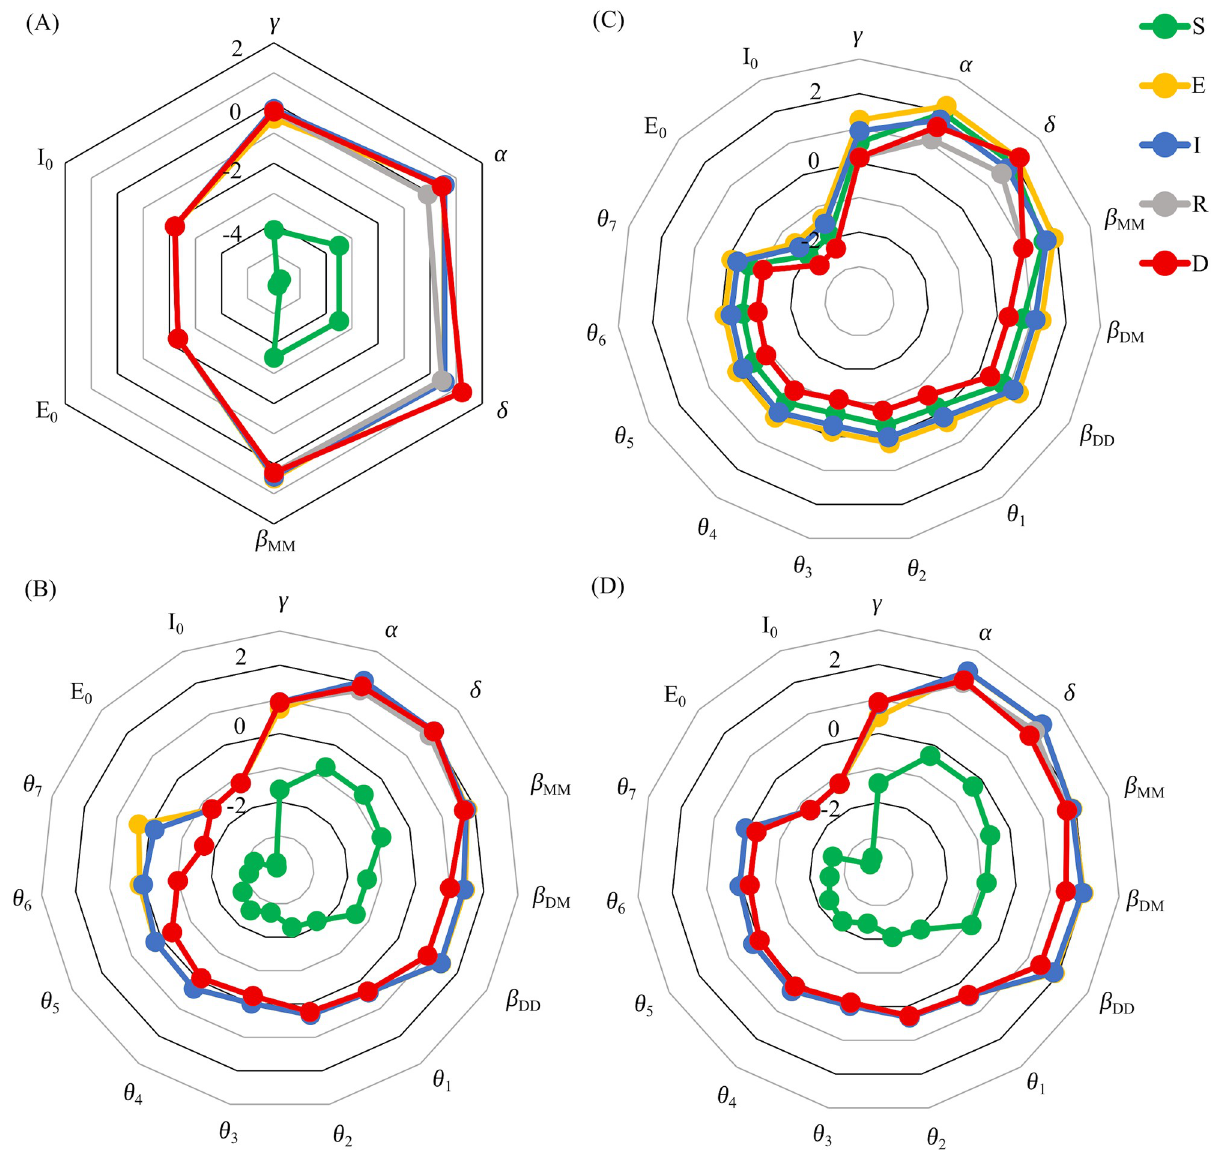
Fig 11. Relative sensitivities of the outputs of the Distancing-SEIRD model on the fit data. Perturbations of Eqs (3) and (4), to perturbations in the parameter values and initial conditions. Each parameter was perturbed by + 1% and initial conditions were perturbed by + 1 from their nominal values in Table 1. In all plots, the public response function θ ( t ), for t � t = 157 days, is fit from epidemiological data, see Fig 3. (A) Simulation time of 52 days, n prior to the start of public health measures. (B) Simulation time of 157 days, capturing the full interval of the epidemiological data. (C) Simulation time of 300 days, where θ ( t > t ) = 0. (D) Simulation time of 300 days, where θ ( t > t ) = n n